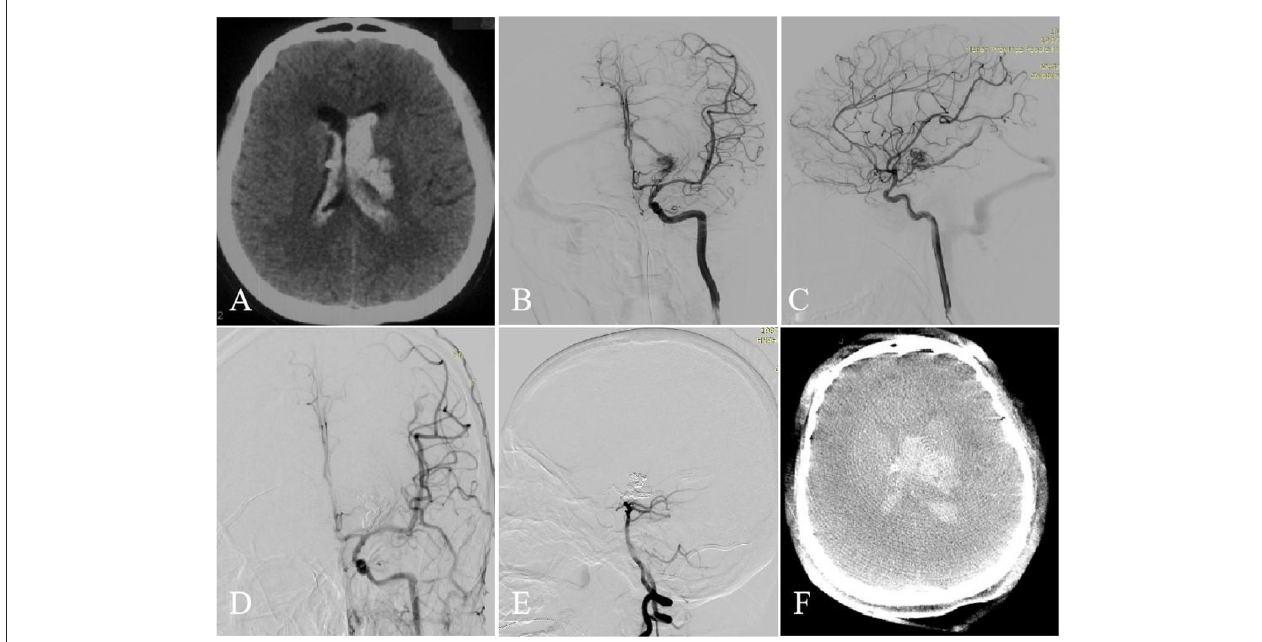
FIGURE 1 | A 31-year-old woman with left basal ganglia AVM. Intraventricular hemorrhage occurred ( A , CT). Selective DSA of the left ICA [anteroposterior (B) and lateral (C) views] demonstrated that the AVM is fed by the ACA, AcrA, and PCA and drained a single venous outlet via the VG. At the end of the operation, the AVM did’t appear at the last angiography [anteroposterior (D) and lateral (E) views]. Intraoperative intraventricular hemorrhage occurred ( F , Dyna CT).